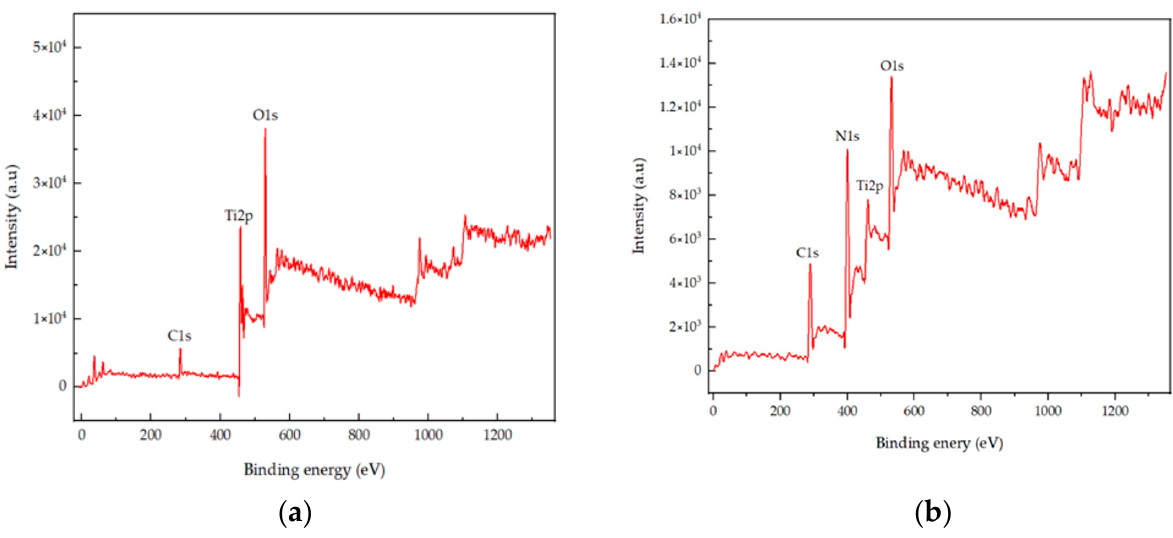
Figure 2. ( a ) XPS survey spectra of TiO 2 and ( b ) XPS survey spectra of N-TiO 2 .